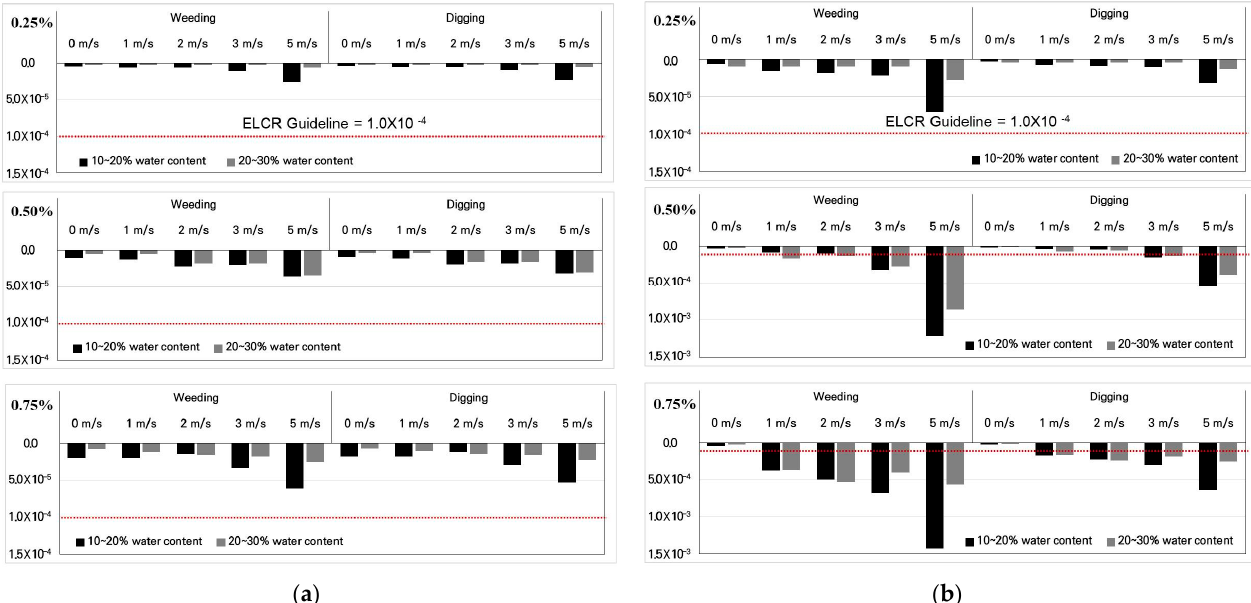
Figure 4. Calculated ELCR value as an asbestos concentration in soils from the Jecheon mine ( a ) and the Jongmin-ri mine ( b ).